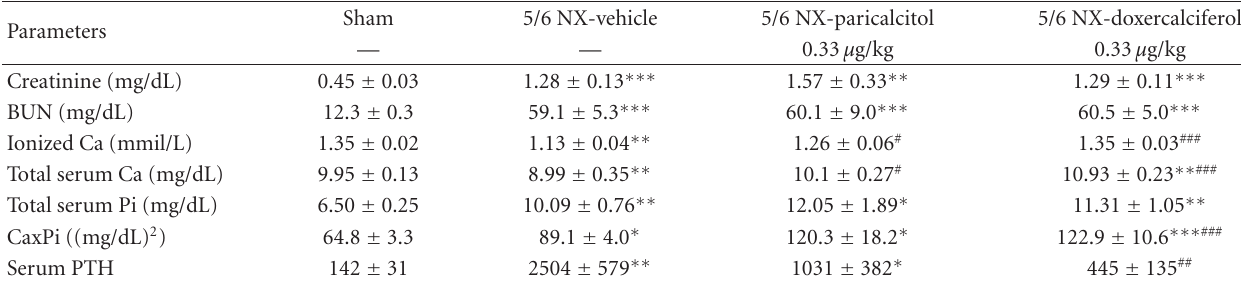
Table 1: Physiological parameters in Sham rats or 5/6 nephrectomized rats fed a hyperphosphatemia-inducing diet. Parameters